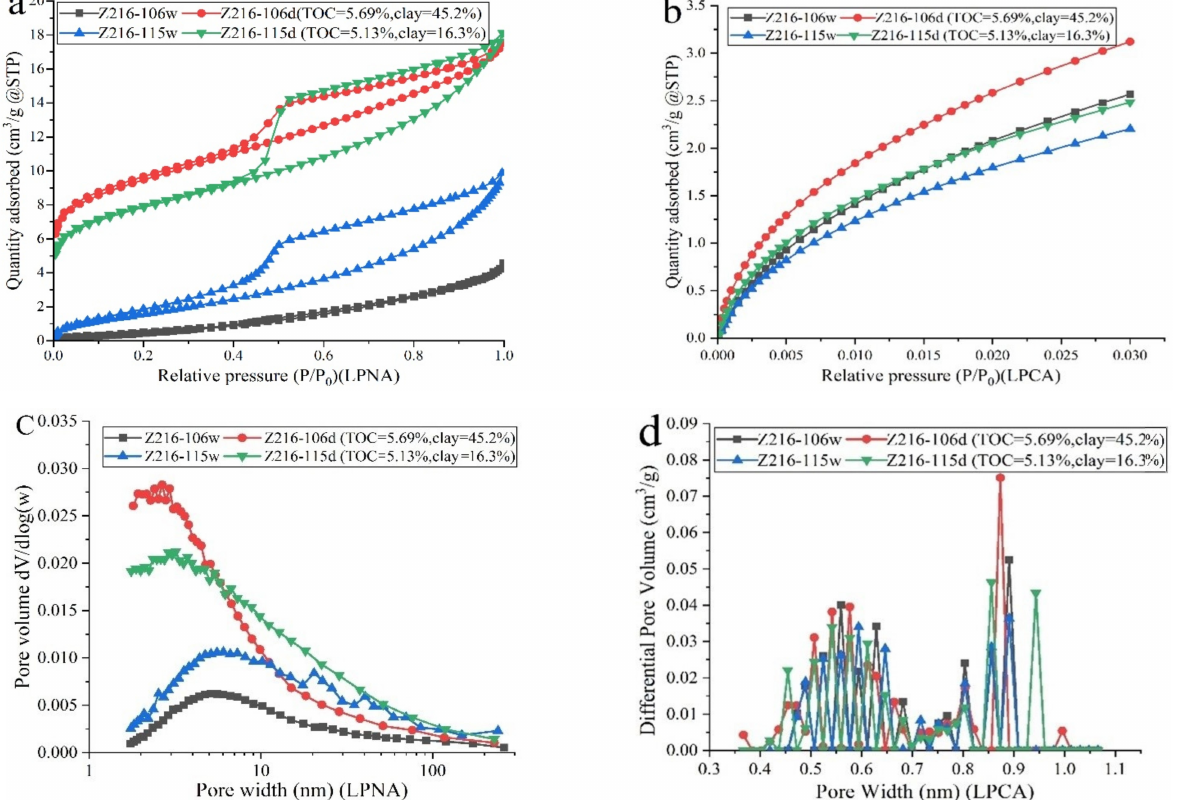
Figure 10. Low-pressure gas adsorption curve ( a , b ) and pore size distributions ( c , d ) of typical deep shale samples in the Luzhou